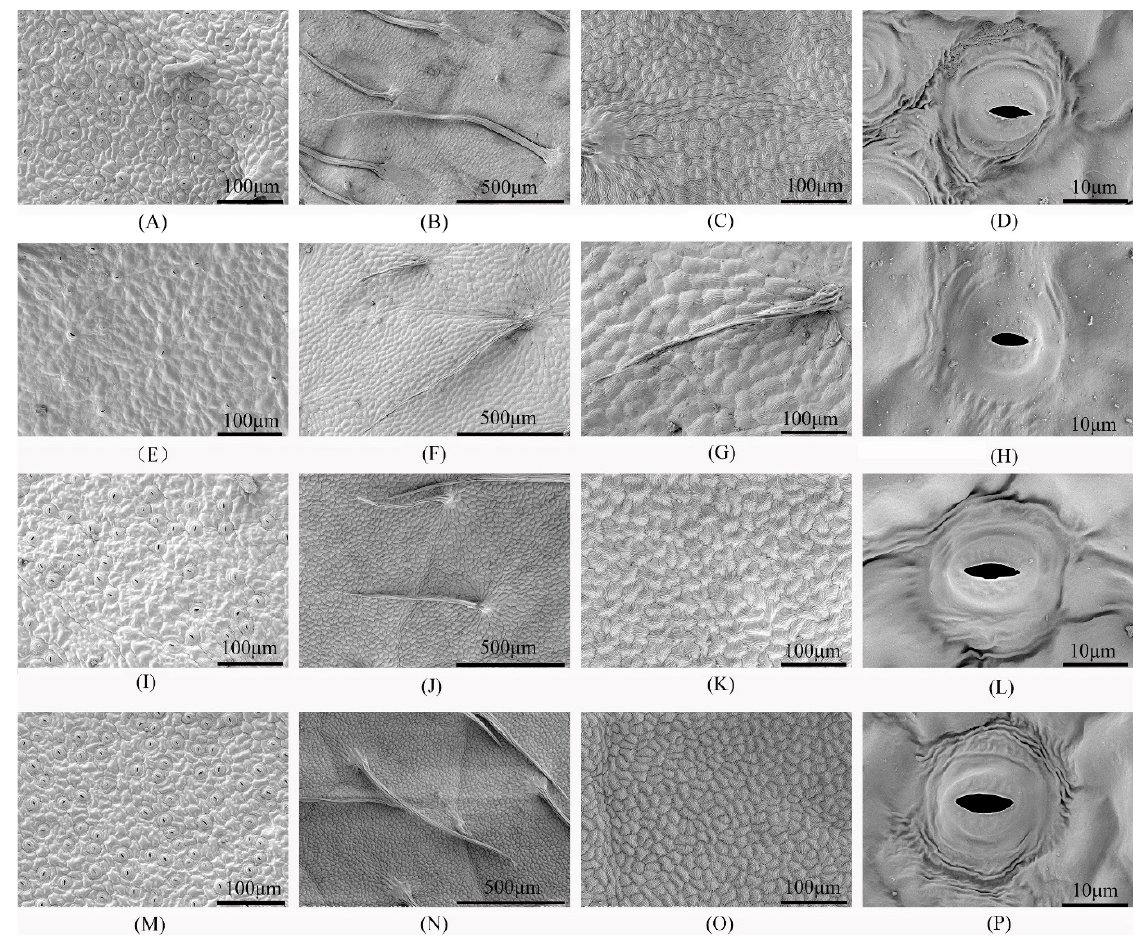
Table 2. Ultrastructure of leaf epidermal cells of Rhododendron × pulchrum leaves under the four treatments.